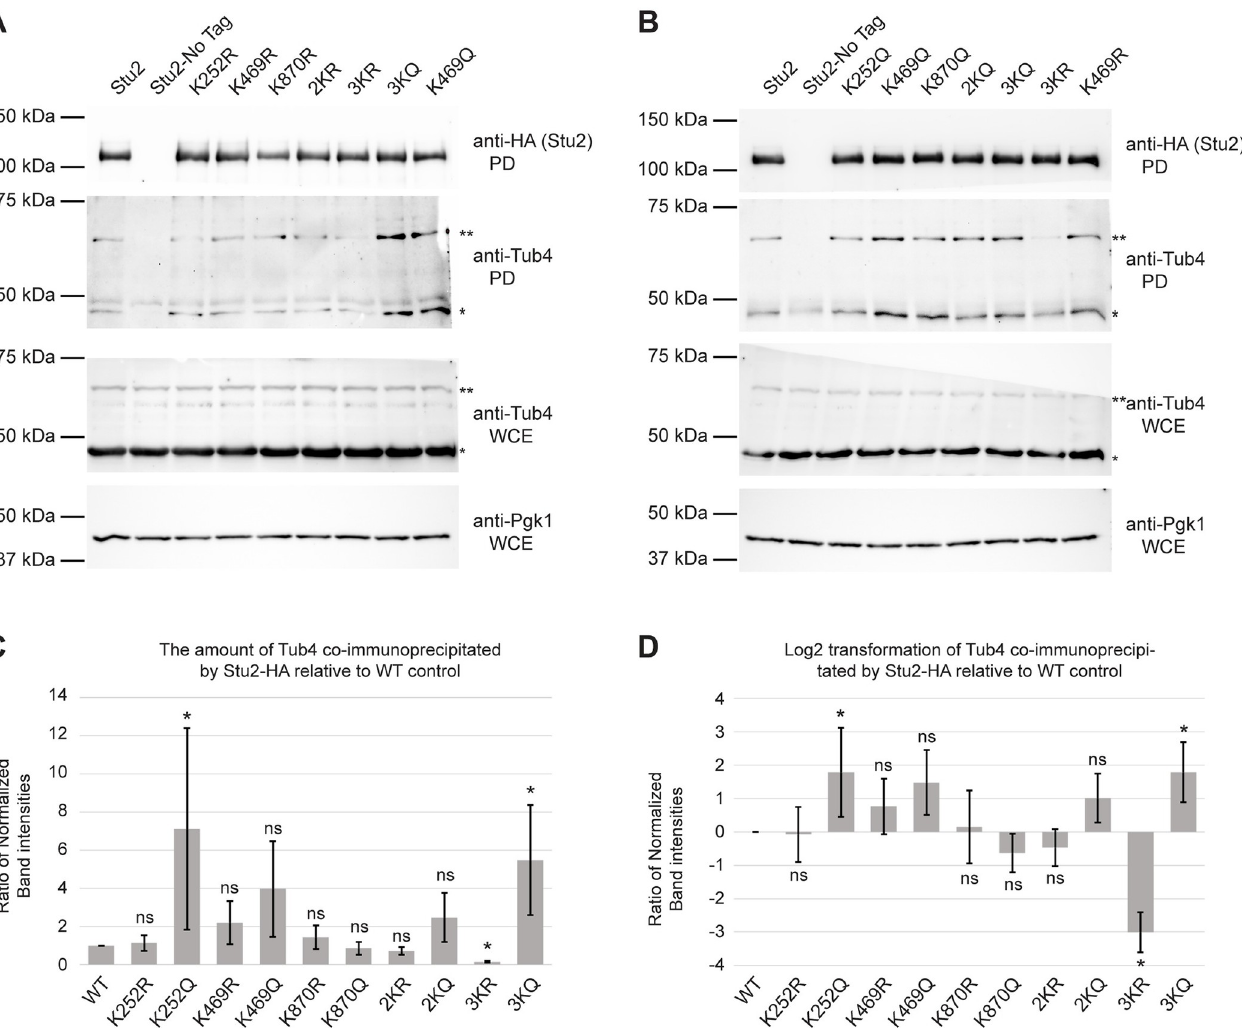
Fig 10. The acetyl-mimetic K252Q and 3KQ mutants increase Stu2 interactions with γ -tubulin. (A,B) Yeast expressing Stu2-HA (yRM12358), untagged Stu2 (yRM12359) K252R (yRM12419), K469R (12361), K870R (12362), 2KR (yRM12363), 3KR (yRM12364), K252Q (yRM12365), K469Q (yRM12366), K870Q (yRM12367), 2KQ (yRM12368), and 3KQ (yRM12369) were immunoprecipitated in PBS buffer and western blotted for HA tagged Stu2. To detect co- precipitation of γ -tubulin, pull-downs were also probed with anti-Tub4. To evaluate γ -tubulin abundance and confirm uniform loading of protein, WCEs were western blotted for γ -tubulin and Pgk1. (C) To examine the impact of Stu2 acetylation on its interaction with γ -tubulin, the ratio of co-immunoprecipitated γ - tubulin relative to enriched Stu2 acetyl-mimetic mutants was determined. The error bars represent the mean ± SEM from three biological replicates. The raw quantitative data are available in S1 Supplementary file. (D) To illustrate the reductions and increases in the affinities of Stu2 mutants for γ -tubulin, the Log2 transformation of ratios (from panel C) is shown. The error bars represent the mean ± SEM of the Log2 transformation from three biological replicates. Student’s t-tests performed on densitometry values prior to normalization to WT controls; � p < 0.1. ns denotes not statistically